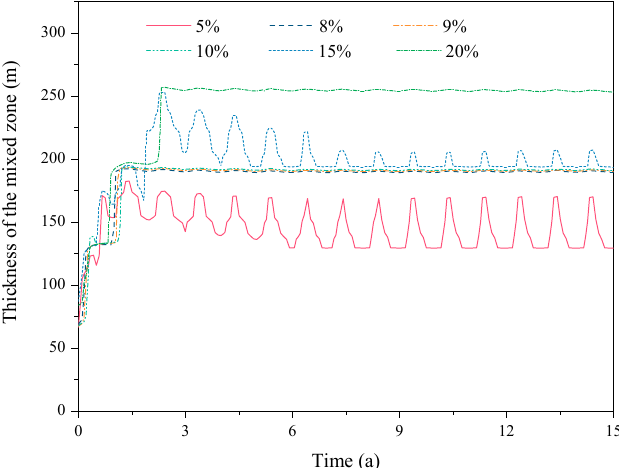
Figure 8. Thickness of the mixed zone for the UGSR with different concentration of CO 2 as cushion gas.